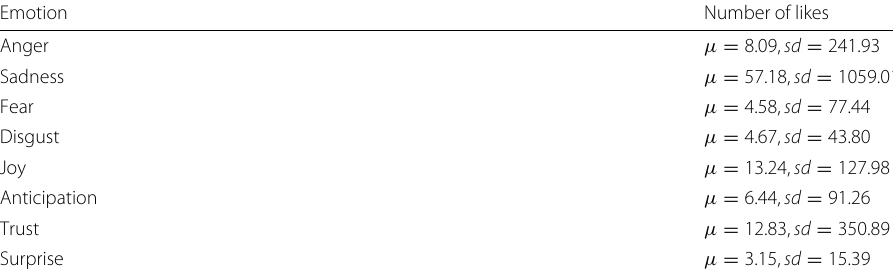
Table 6 Average number ( μ ) of likes and its standard deviation ( sd ) endorsed to a tweet conveying a particular